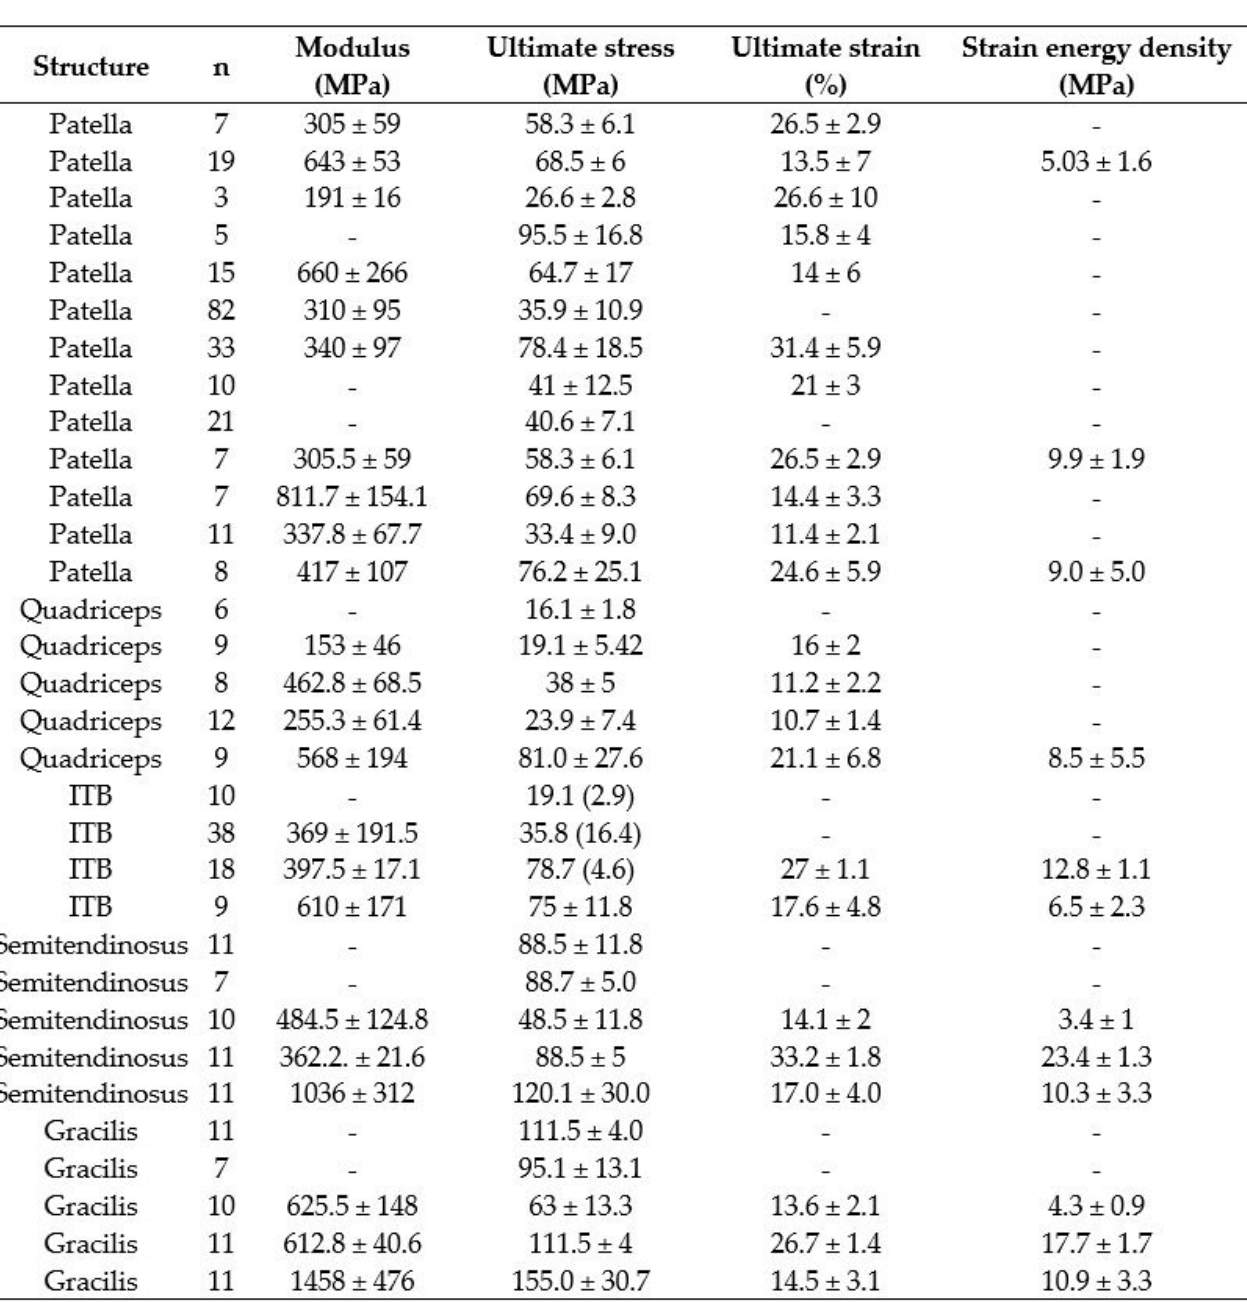
Figure 1. Diversity of results [8] (reprinted from K. Smeets, J. Bellemans, L. Scheys, B. O. Eijnde, J. Slane, S. Claes (2017)).